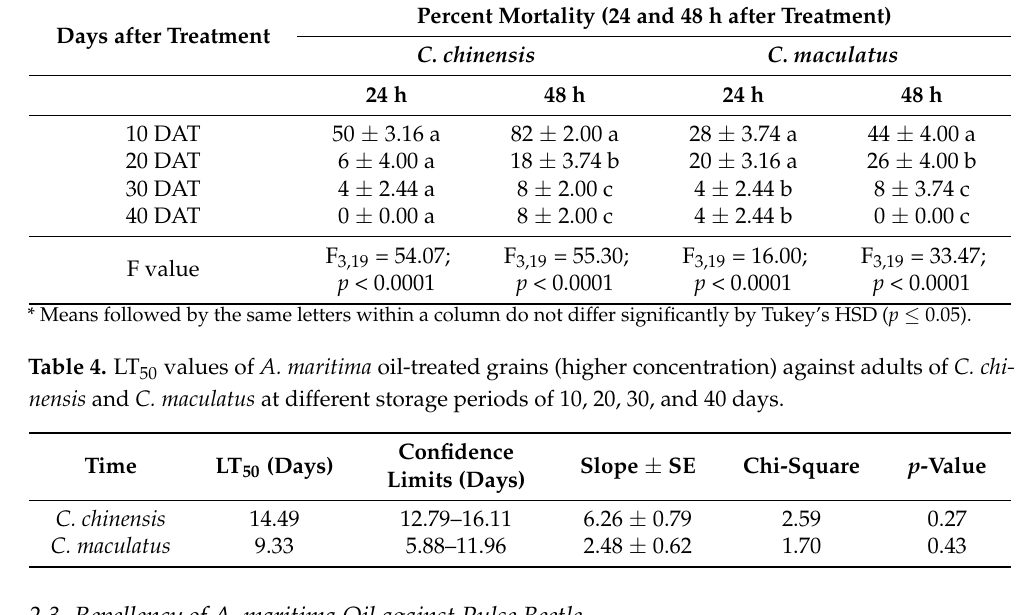
Table 3. Residual toxicity of C. chinensis and C. maculatus adults fed A. maritima oil-treated grains stored for different periods.